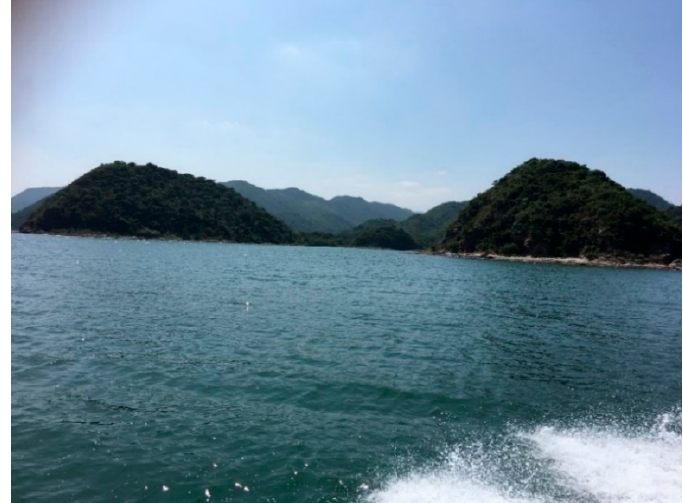
Figure 4. Hong Kong UGGp, China—View of the island landscape.